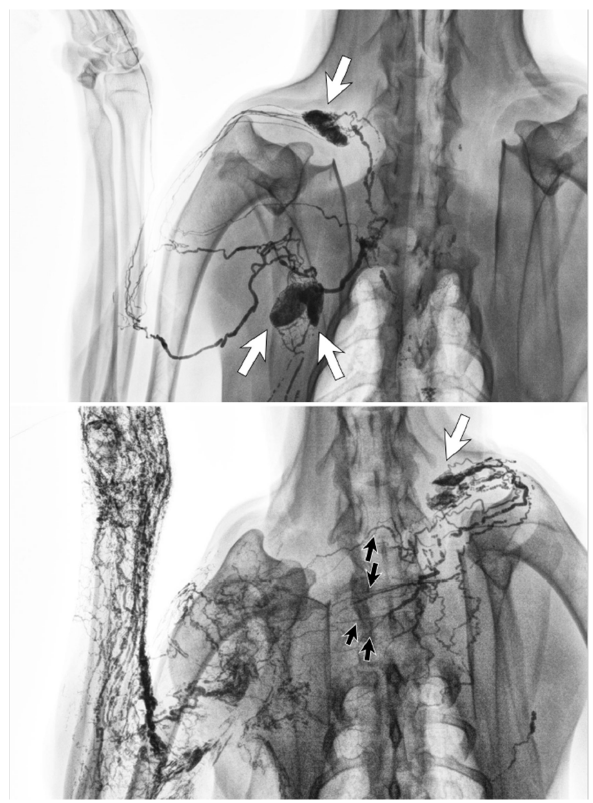
Figure 6. Lymphangiography images of a canine before lymph node dissection surgery (top) and six months afterwards (bottom). The lymphatic vessels from the left forelimb crossed the front midline and connected to the right cervical lymph node (white arrow) via regenerated lymphatic vessels (black arrows). (Reproduced from [36] with permission.).